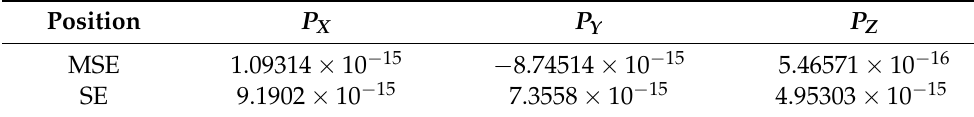
Figure 16. Simulations of position and orientation error synchronization between an upper-limb exoskeleton and virtual object. ( a ) Mean Square Error of the position synchronization ( P X , P Y , P Z ). ( b ) Mean Square Error of the orientation synchronization ( α , β , γ ). ( c ) Box plot of the position synchronization ( P X , P Y , P Z ). ( d ) Box plot of the orientation synchronization ( α , β , γ ). The Mean Square Error and Standard Error values of the position synchronization are shown in Table 16. The error obtained to give a value approximately to zero, so the position synchronization is fulfilled. Table 16. Mean Squared Error (MSE) and Standard Error (SE) of Position.